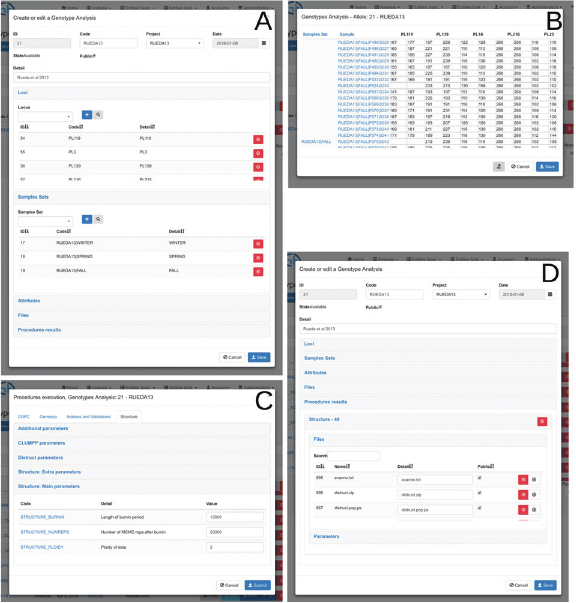
Figure 2 - Genotypes Analysis screens. (A) Edition and creation screen (panel of Loci and Samples Sets); (B) query and edition screen of alleles included in the genotypes analysis; (C) screen of analysis procedures exe- cution; (D) edition and creation screen (procedures results